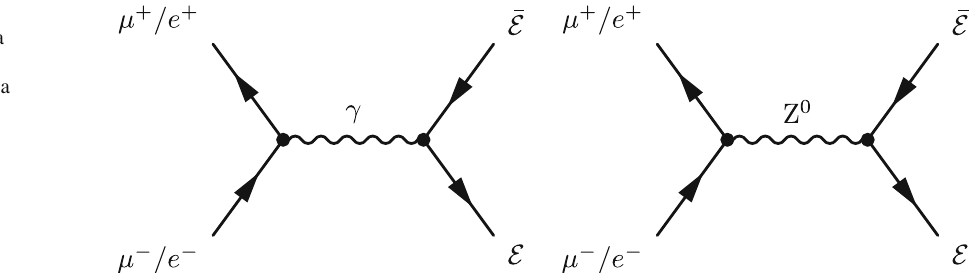
Fig. 5 LO Feynman diagrams for VLL double production at a lepton/anti-lepton collider via exchange of either a photon or a Z 0